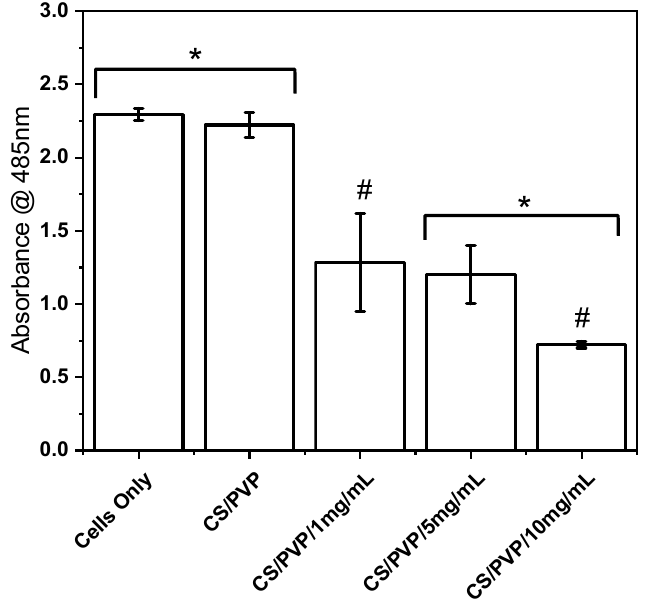
Figure 9. Cell viability measured using a WST-8 assay after 24 h exposure to constructs (37 °C, 5% CO 2 ). Absorbance was measured at 485 nm; high absorbance indicates high cell viability. Groups containing 1, 5 and 10 mg/mL all contained 5-Fu. Here, * denotes statistical significance between control groups and experimental groups containing 5-Fu. # denotes statistical significance between concentrations of 5-Fu in the CS/PVP groups. Two sample t -test, p < 0.05, n = 3.